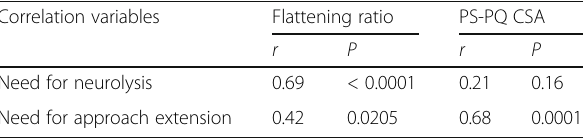
Table 3 Correlation between the relevant operative data and ultrasonographic